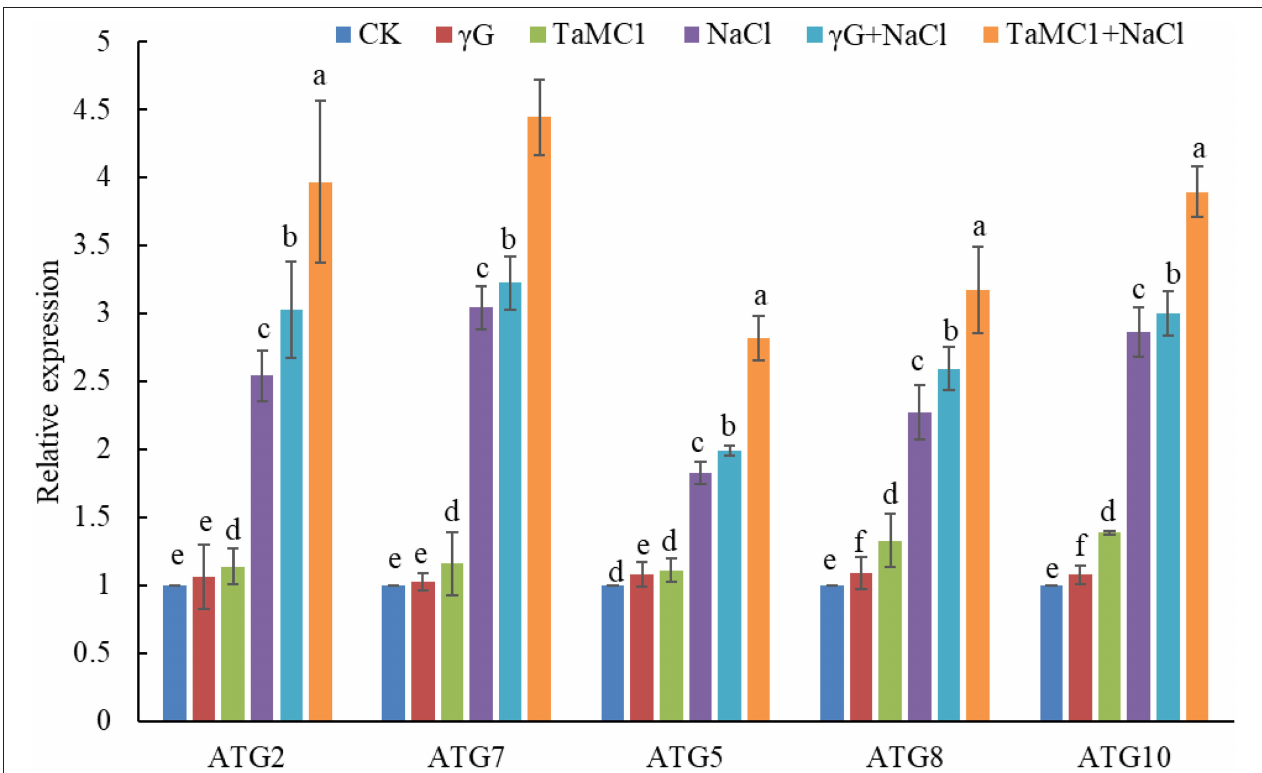
FIGURE 4 | The effect of silencing of TaMCA-Id on the relative expression analysis of key ATGs in leaves of wheat seedlings under NaCl stress. CK was the wild-type wheat seedlings. γ G was the BSMV-VIGS-GFP - inoculated wheat seedlings. TaMC1 was the BSMV-VIGS-TaMCA-Id - inoculated wheat seedlings. Data are shown as mean ± SD ( n = 3) of three independent experiments. The different letters in each treatment show the significant difference ( P <